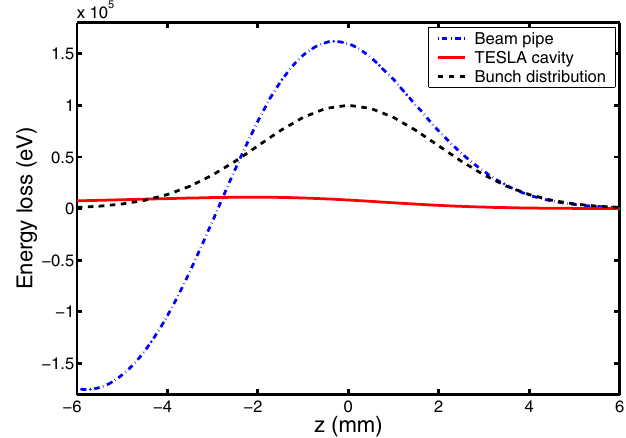
FIG. 7. (Color) Comparison between the energy loss of a parti- cle in a 2 mm Gaussian bunch due to tesla cavity and DA (cid:1) NE vacuum chamber